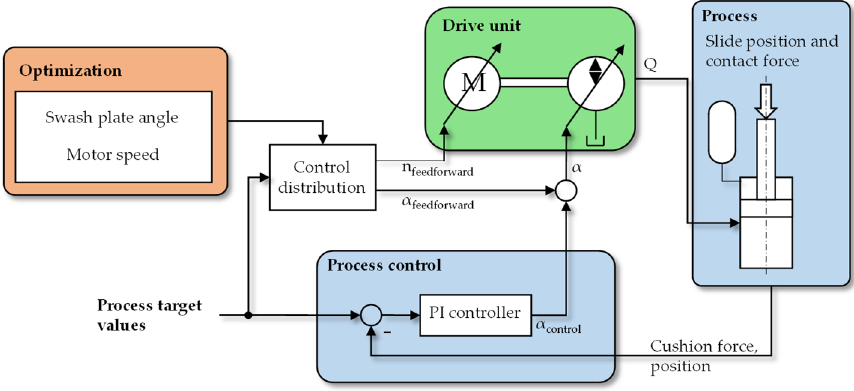
Figure 5. Schematic representation of the implementation of the drive unit with two control variables and offline optimization for the control variable distribution.